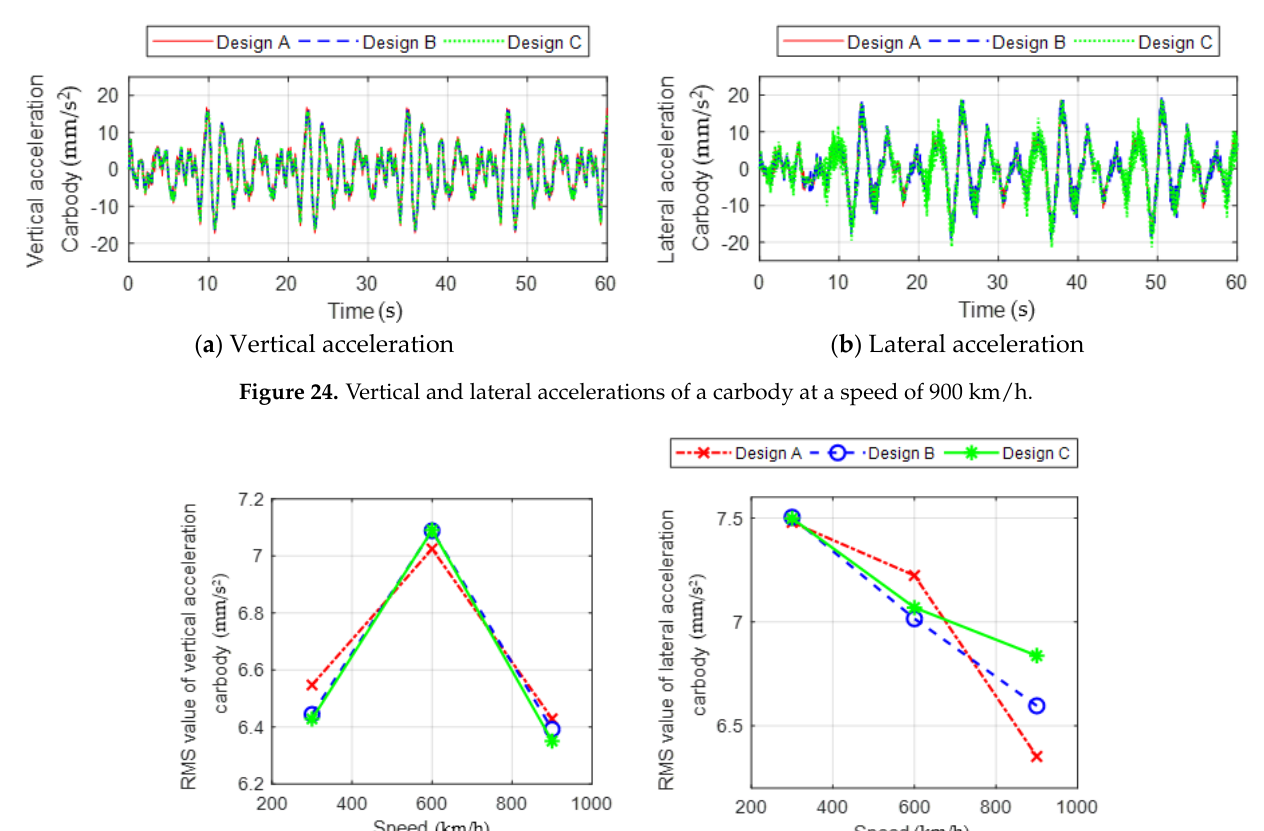
20 of 22 Figure 22. Vertical and lateral accelerations of a carbody at a speed of 300 km/h. ( a ) Vertical acceleration ( b ) Lateral acceleration Figure 23. Vertical and lateral accelerations of the carbody at a speed of 600 km/h. Figure 24 shows the vertical and lateral accelerations of the three designs when run- ning at a high speed with v = 900 km/h. The vertical and lateral accelerations of the carbody are maintained within ±20 mm/s (cid:2870) , similar to the result at an earlier lower driving speed. In addition, the vertical and lateral accelerations have an oscillation period of approxi- mately 12 s after running for approximately 10 s. The three designs show similar results with respect to the vertical acceleration of the carbody; however, in the case of the lateral acceleration, Design C shows a higher magnitude than the other two designs. Figure 25 shows the comparison result of the RMS values of the vertical and lateral accel- erations with respect to the speed for Designs A, B, and C. The vertical acceleration of the carbody for all the three designs increased by approximately 0.6 mm/s 2 at medium speed and